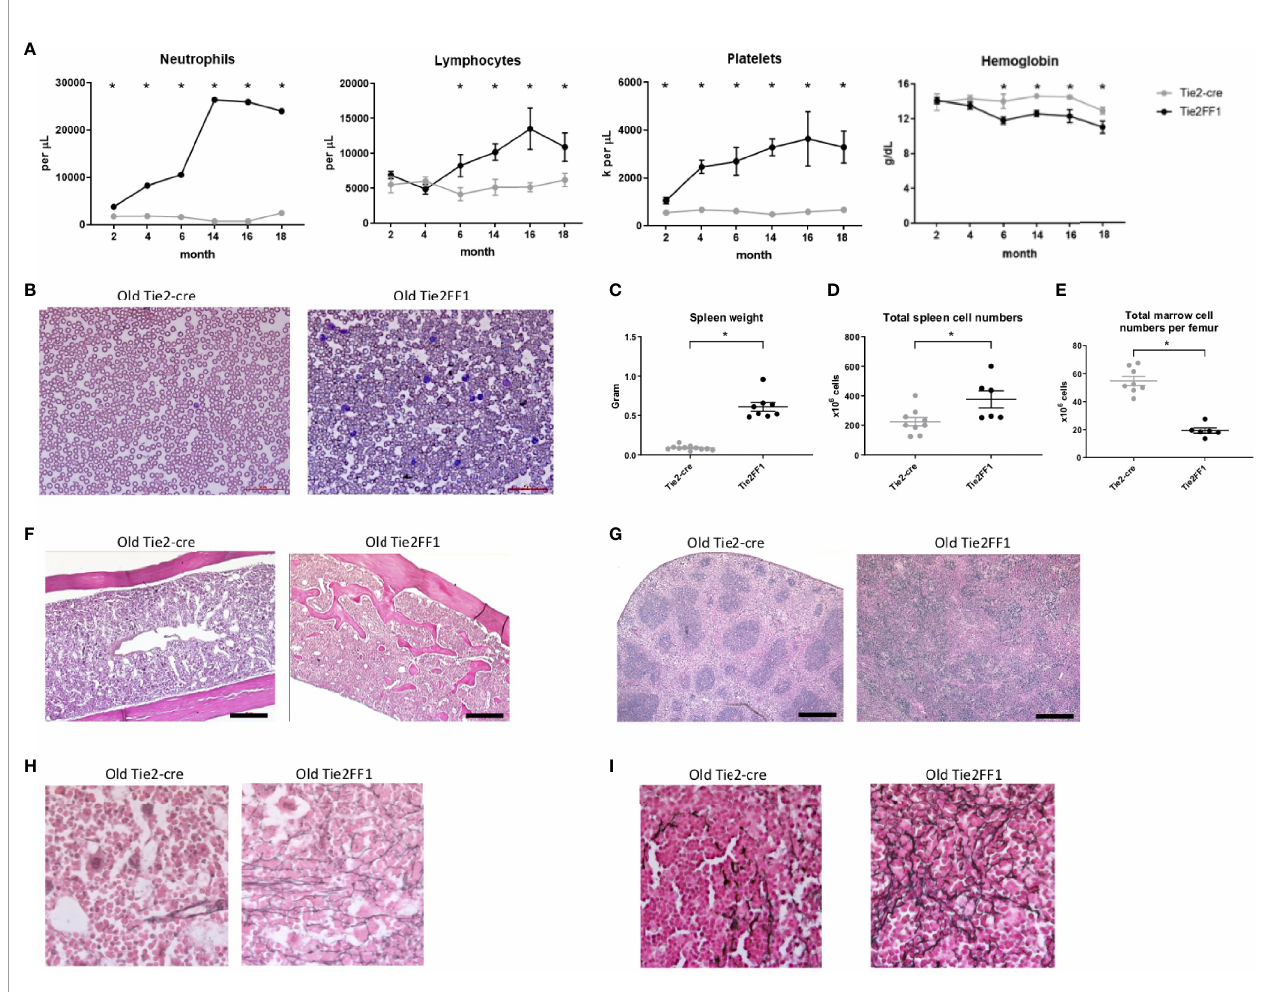
FIGURE 1 | The Tie2FF1 mice develop ET to PMF transformation during aging. (A) Peripheral blood cell counts of Tie2FF1 (black line) and Tie2-cre control mice (grey line). (n=5-10 mice in each group at 2mo and 4mo; n=6-7 mice in each group at 6mo, 12mo, and 15mo; n=10 mice in each group at 18mo). (B) Representative peripheral blood smear of 18mo old Tie2-cre and Tie2FF1 mice (40X magni fi cation). (C – E) Spleen weight (C) , total spleen cell counts (D) , and total femur cell counts (E) in 18mo old Tie2-cre and Tie2FF1 mice (n=10 mice in each group). (F, G) Representative hematoxylin and eosin sections of marrow (F) and spleen (G) from 18mo old Tie2-cre and Tie2FF1 mice [ F : 1OX magni fi cation, scale bar: 1OOuM; (G) 4X magni fi cation, scale bar: 500uM]. (H, I) Representative reticulin stain of marrow (H) and spleen (I) from 18mo old Tie2-cre and Tie2FF1 mice (40X magni fi cation). * P <